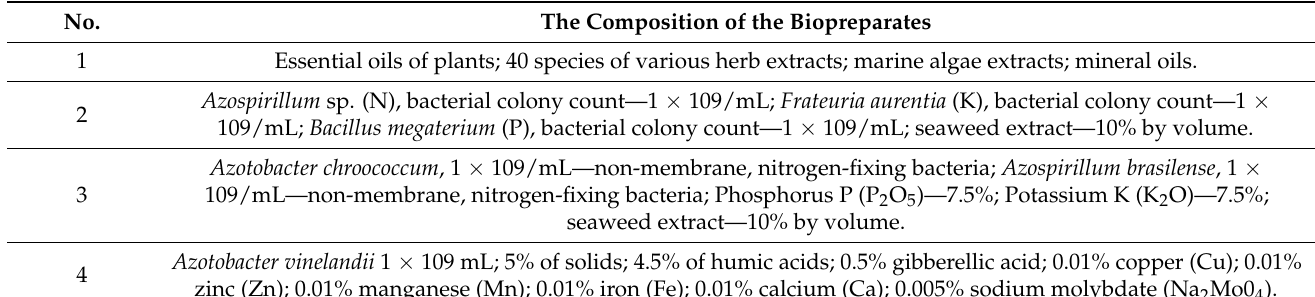
Table 1. Compositions of